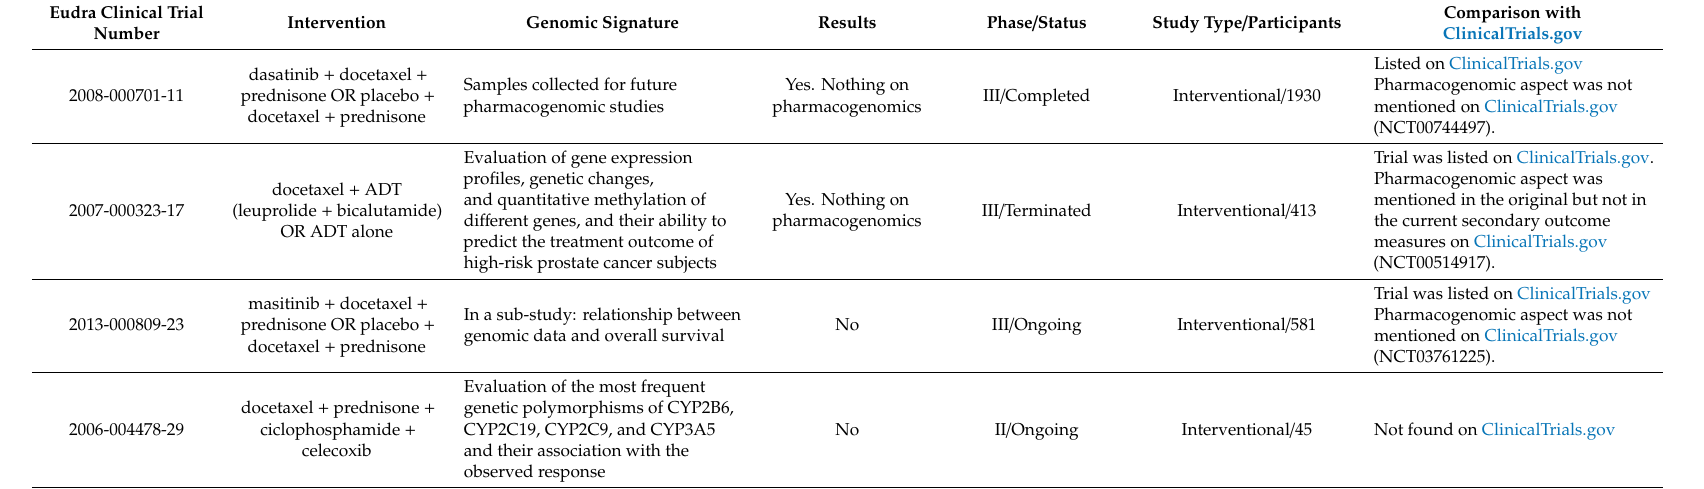
Table 4. Clinical trials for docetaxel treatment in prostate cancer in EU Clinical Trials